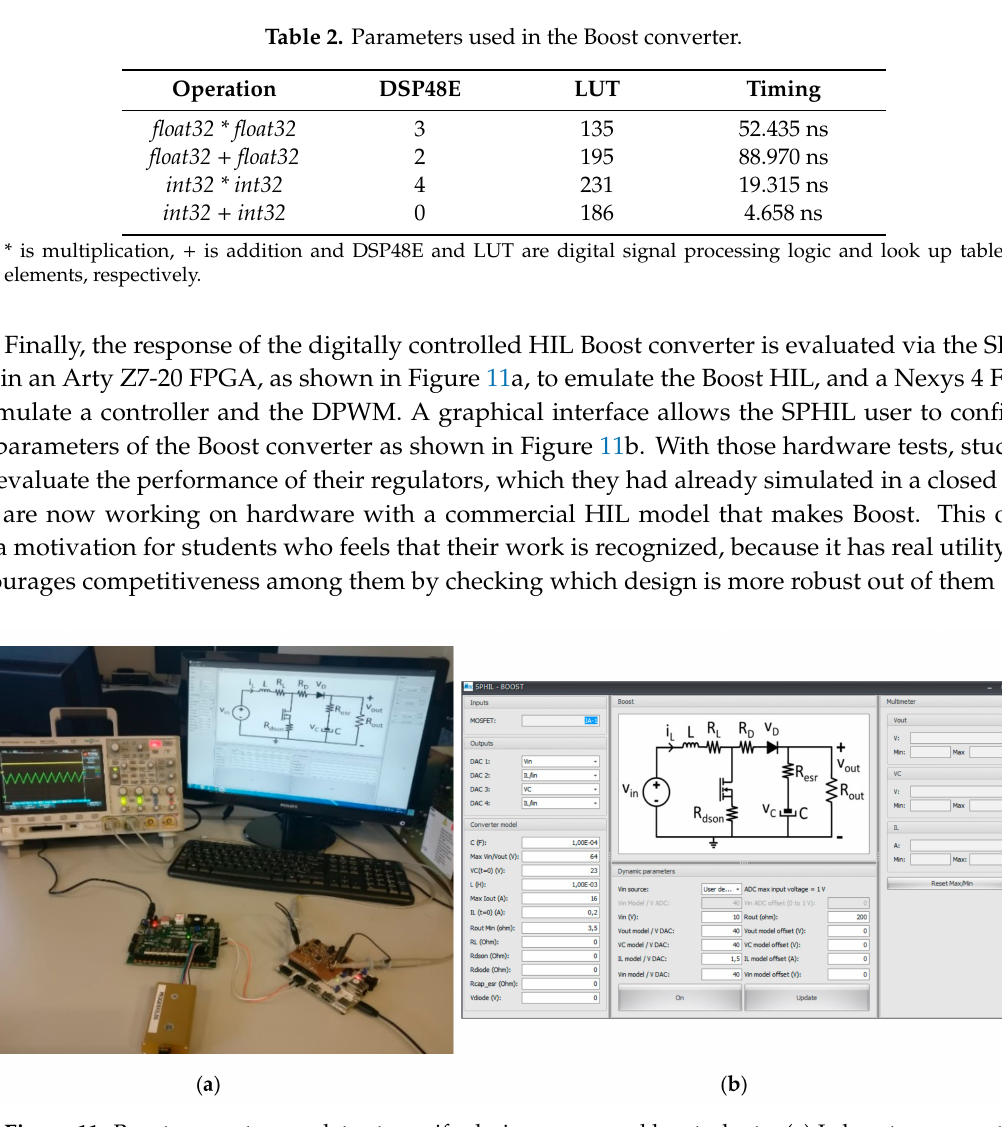
Figure 11. Boost converter emulator to verify designs proposed by students. ( a ) Laboratory mount configuration and ( b ) SPHIL graphical user